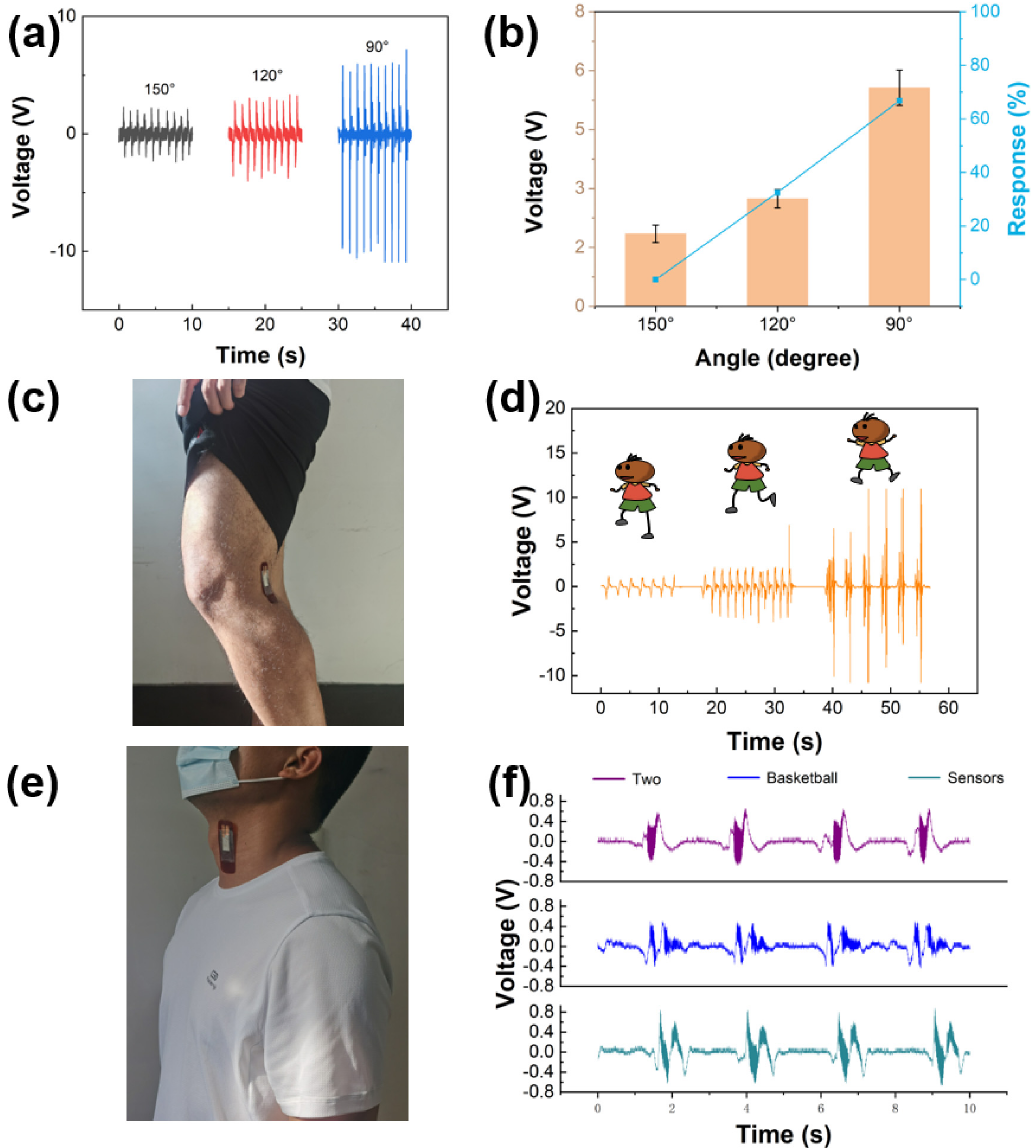
Figure 6. ( a ) Output piezoelectric voltage of accuracy experiment. ( b ) Output piezoelectric voltage response of accuracy experiment. ( c ) Optical image of the sensor is attached on the popliteal fossa. ( d ) Output piezoelectric voltage of popliteal fossa of sensor as the tester is walking, running, and jumping. ( e ) Optical image of the sensor is attached on the adam’s apple. ( f ) The different signals output by the sensor when tester says different words.